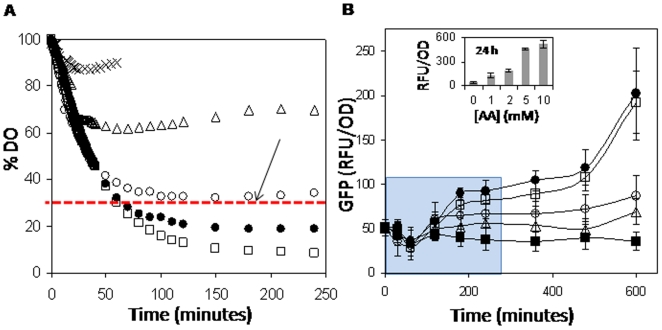
AA-mediated O2 scavenging results in induction of DevR-regulated promoter activity.(A) Time dependent depletion of dissolved O2 (DO) in Dubos medium with AA concentrations of 1 mM (Δ), 2 mM (○), 5 mM (•), 10 mM (□), 10 mM DHA (×), expressed as% of initial value (saturation). (B) Rv1738 promoter activity leads to induction of GFP fluorescence (expressed in RFU/OD) in AA-treated shaking M. tb cultures. Data is shown as mean ± SD (n = 6) for 0 mM (▪), 1 mM (Δ), 2 mM (○), 5 mM (•), 10 mM (□) of AA. Inset in (B) shows promoter activity in AA-treated cultures at 24 h. The first time point showing a statistically significant induction is shown by the red arrow on the red line in (A). The data that was subjected to statistical analysis is shown in a blue shaded rectangle.